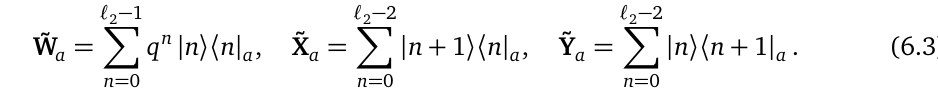
Figure 3: The decomposition of S − where ∗ represents non-zero elements of the matrices. As in Fig. 2 the bottom-right entry corresponds to | 0 〉〈 0 |